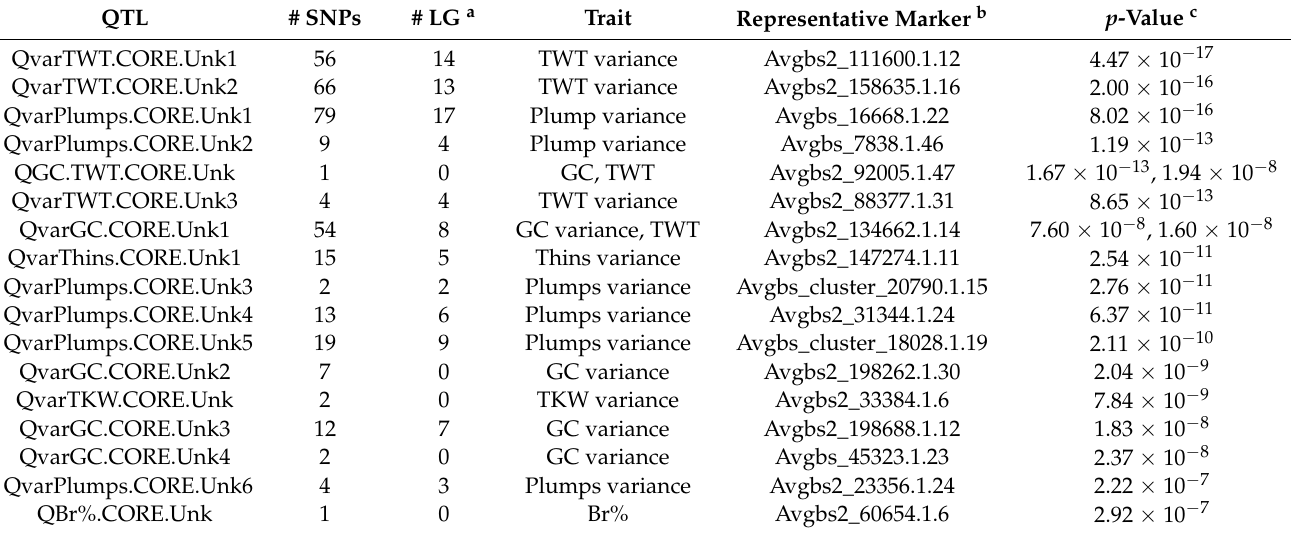
Table 4. Summary of uncertain genomic location quantitative trait loci associated with milling trait means and variances across location years. The number of non-independently associated SNPs, the number of linkage groups represented by those SNPs, trait(s) and the p -value for the representative marker are indicated. p -values for all markers associated with these QTL in all experiments are presented in Supplemental Table S2.